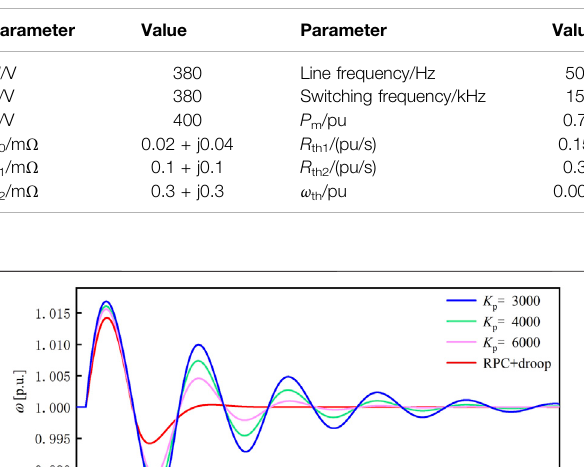
TABLE 2 | Other related parameters of the system.